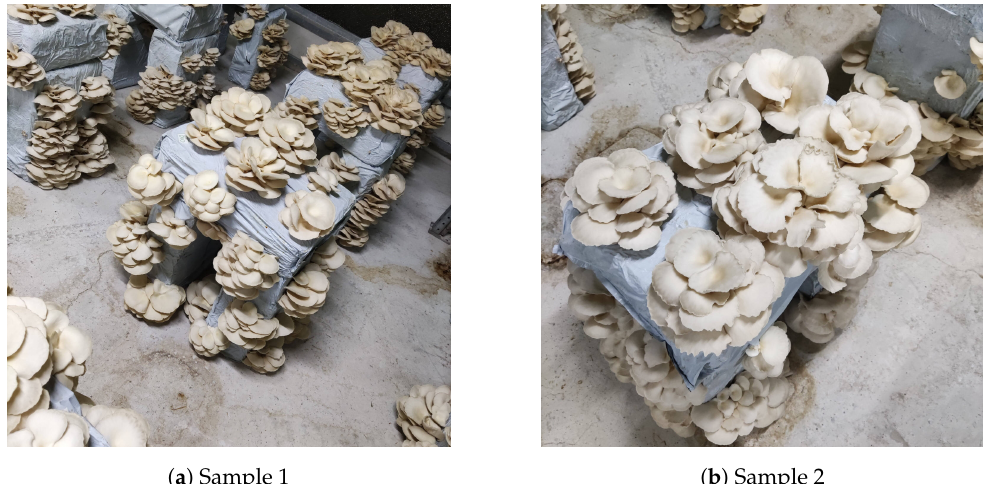
Figure 2. Pictures from the greenhouse with multiple mushrooms.